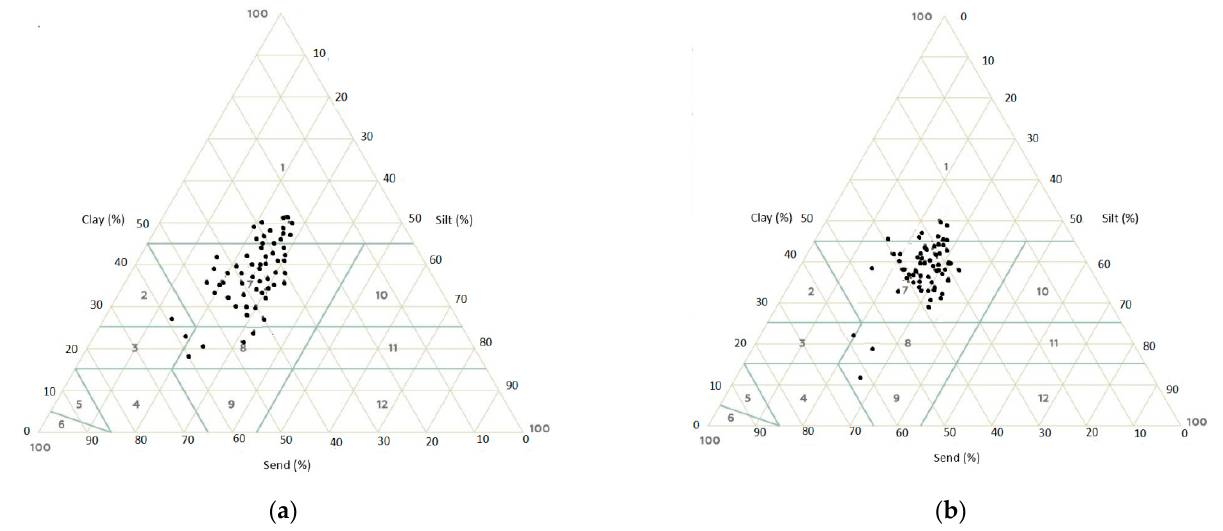
Figure 6. Textural triangle diagram according to International Union of Soil Sciences (IUSS) system of classification of soil particles: ( a ) soil depth 0-30 cm (N = 56) and ( b ) soil depth 30-60 cm (N = 56). Textural classes: 1—heavy clay, 2—sandy clay, 3—sandy clay loam, 4—sandy loam, 5—loamy sand, 6—sand, 7—light clay, 8—clay loam, 9—loam, 10—silty clay, 11—silty clay loam, 12—silt loam.